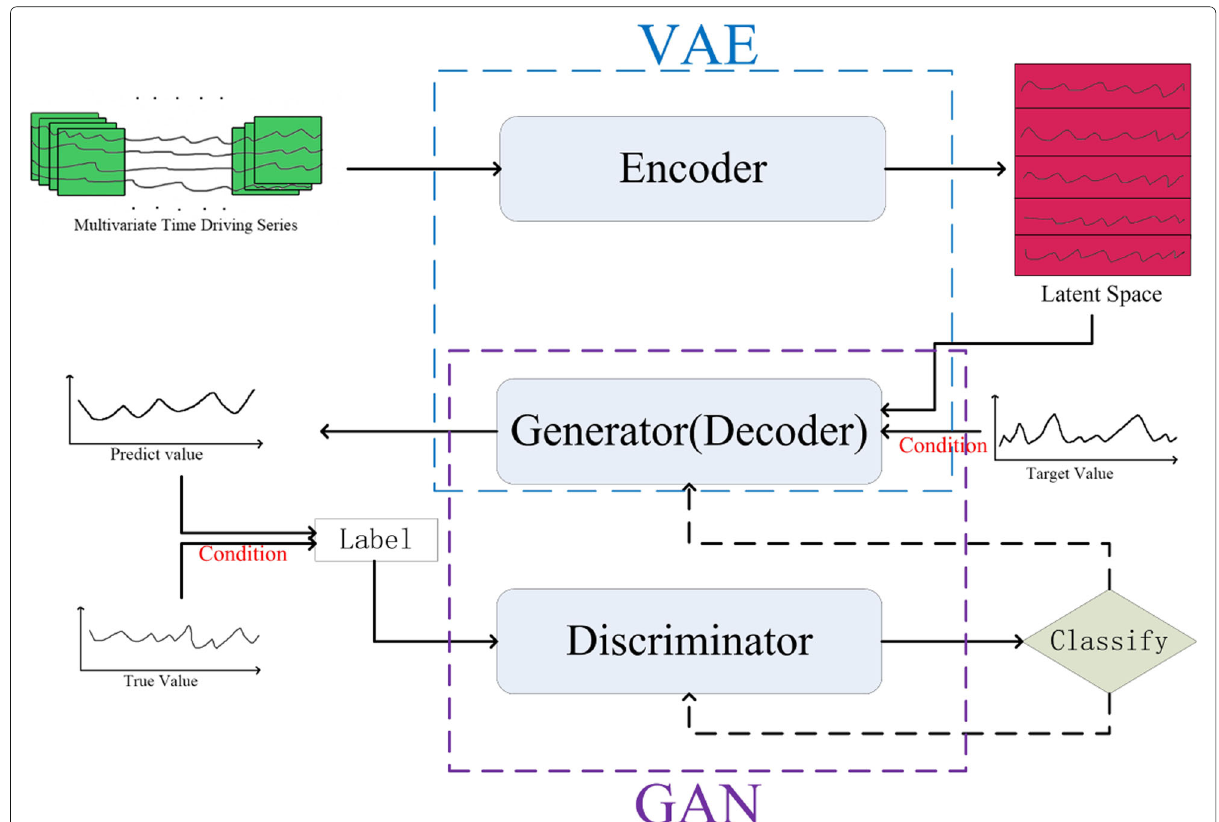
Fig. 1 The Architecture of The VAECGAN